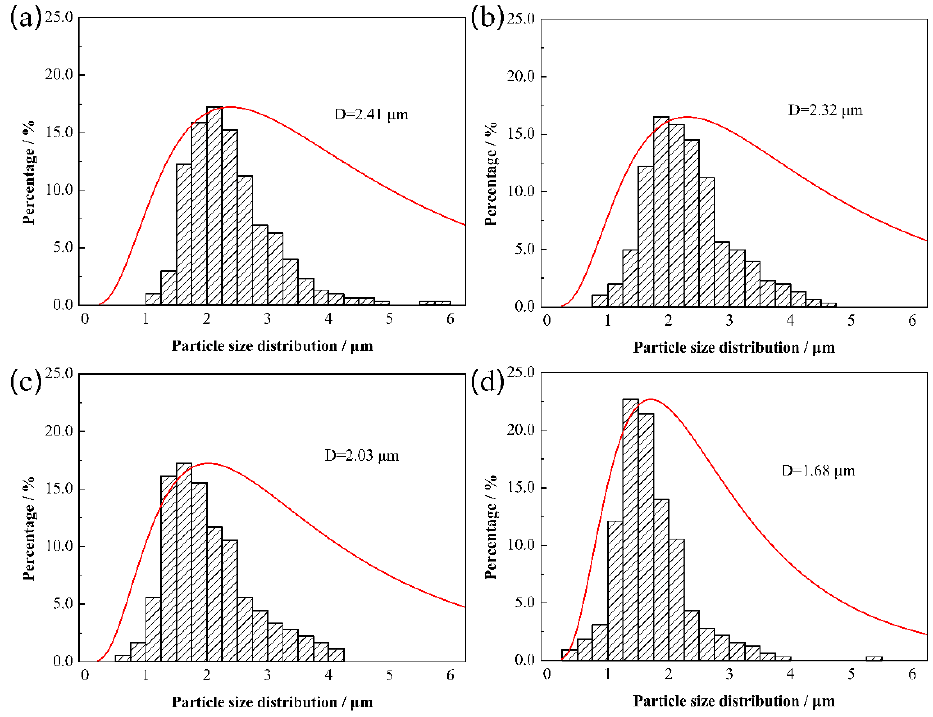
Figure 6. Particle size distribution of Mo 2 FeB 2 with different Mo contents: ( a ) 43.5 wt.%; ( b ) 45.5 wt.%; ( c ) 47.5 wt.%; ( d ) 49.5